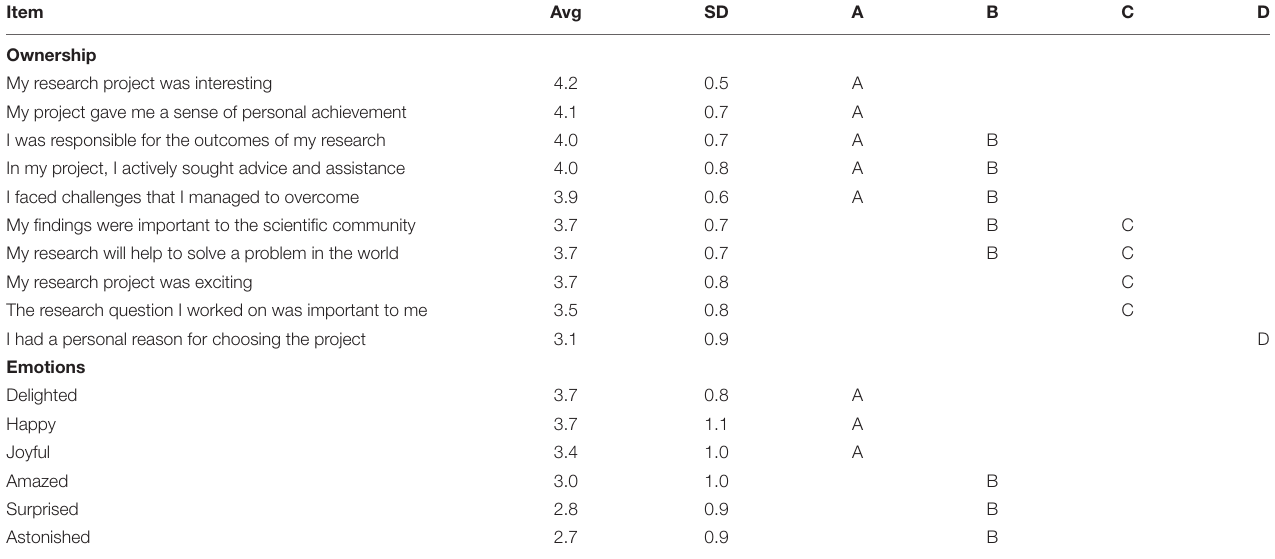
TABLE 4 | Project ownership survey.